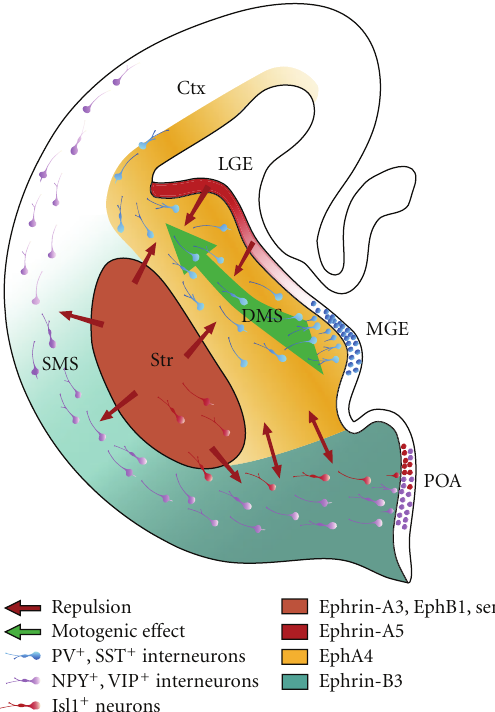
Figure 2: Di ff erent Eph/ephrin members act in concert to channel migrating MGE-derived neurons towards the cortex. Schematic drawing of a coronal brain slice from the right hemisphere; medial is right; dorsal is top. The MGE gives rise to parvalbumin-(PV-) and somatostatin-(SST-) positive interneurons. They are driven by EphA4 reverse signalling and guided by ephrin-A5, ephrin-A3, and Sema3A/3F forward signalling. The POA gives rise to neuropeptide Y (NPY), vasoactive intestinal protein (VIP) as well as islet 1 (Isl1) positive interneurons that are guided by EphB1/ephrin-B3 signalling preventing the POA-derived cortical interneurons from entering the striatum (Str). The same Eph/ephrin signalling allows the Isl1 + neurons to migrate towards the Str. The MGE gives rise to the deep migratory stream (DMS) and the POA provides neurons for the superficial migratory stream (SMS). Those streams are divided by a bidirectional EphA4 and ephrin-B3